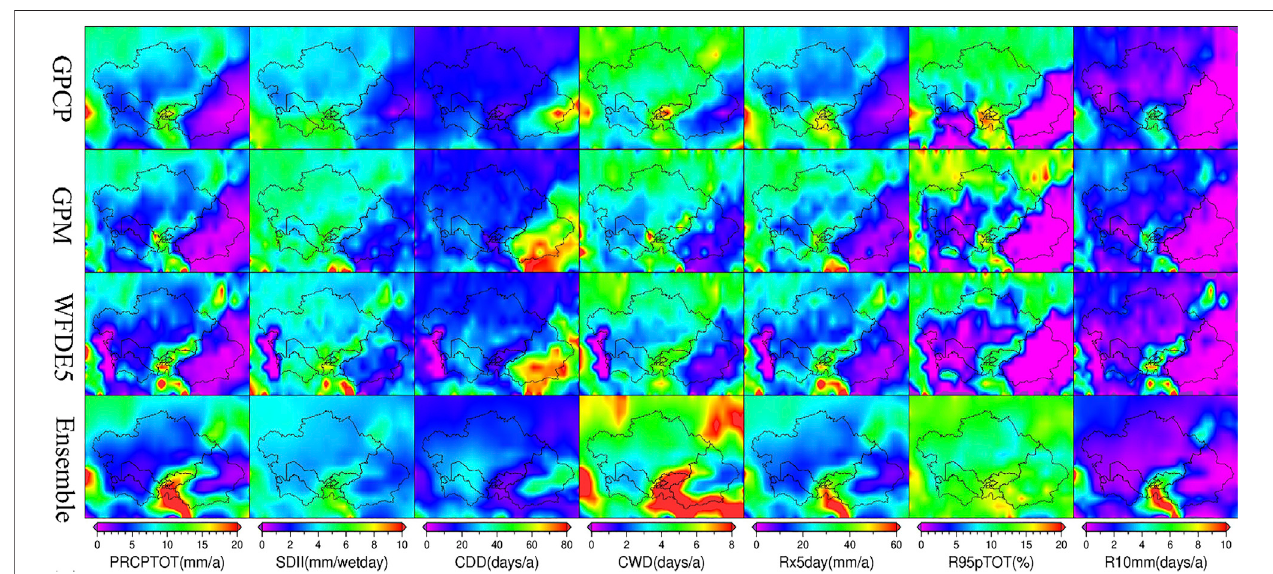
FIGURE 2 | Spatial distribution of spring (MAM) total precipitation and extreme precipitation indices from three observations (GPCP, GPM, and WFDE5) and the CMIP6 multi-model ensemble mean over Central Asia for 2001 – 2014.